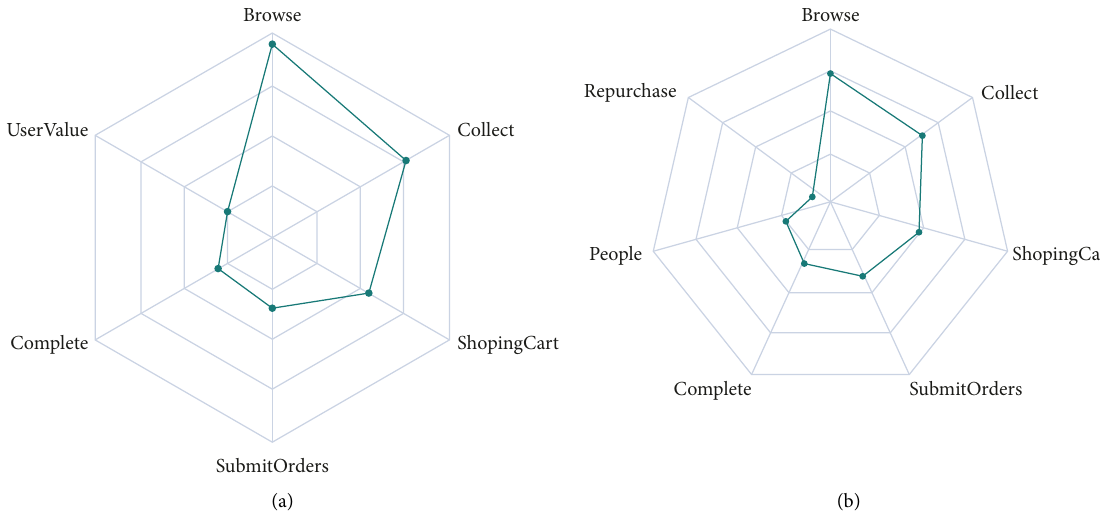
Figure 11: Radar graph visualization based on user behavior. (a) Individual user behavior radar map. (b) Group user behavior radar